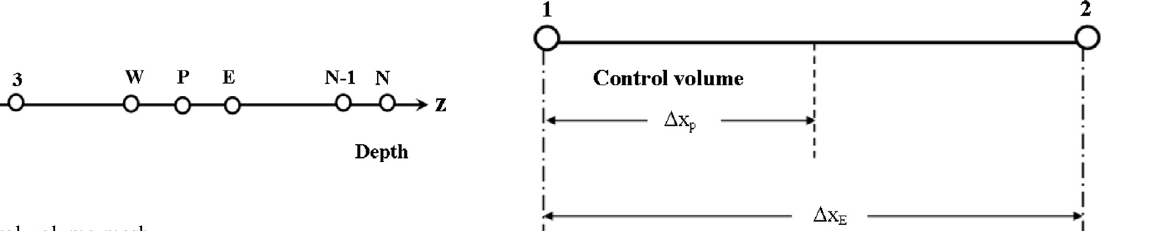
Figure 3. Control volume mesh.